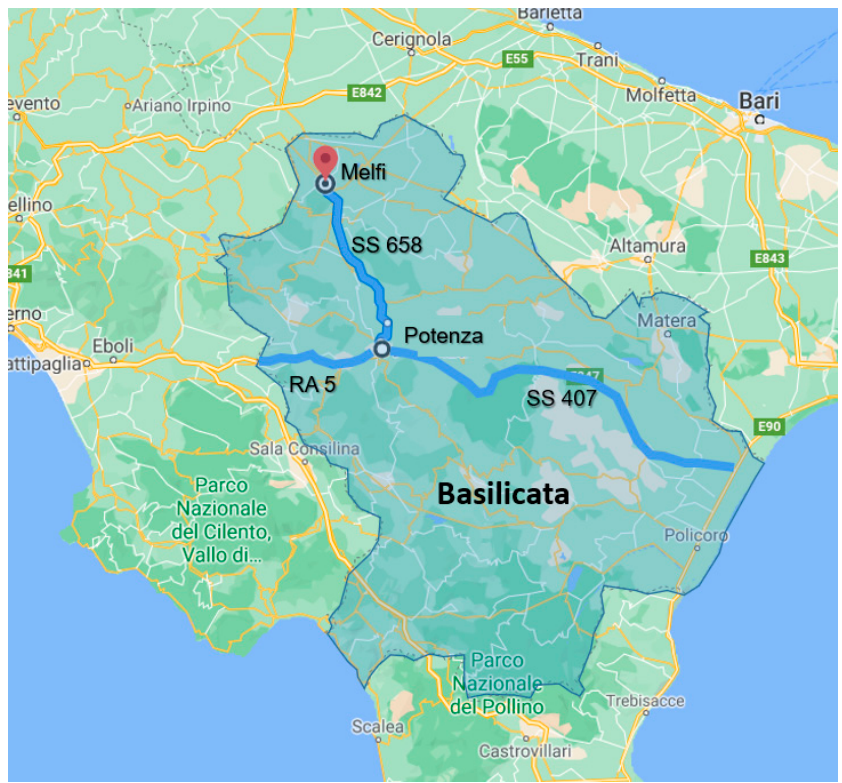
Figure 2. The SS 658 highway (map retrieved from Google Maps on March 2021).